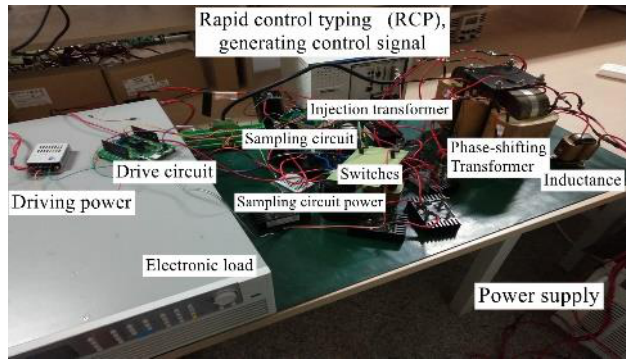
Figure 10. The prototype of the proposed rectifier. When without the suppression method, the input voltage of the rectifier is described as Figure 11. The input voltage in Figure 11 has 18 steps per cycle, the simulated THD of input voltage is 8.7%. Because of the leakage inductance of the main transformer, the experimental value is about 6.8%.